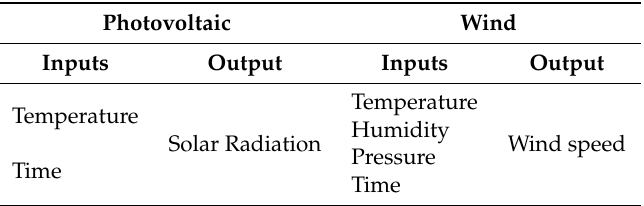
Table 1. Input and outputs parameters for ANN.